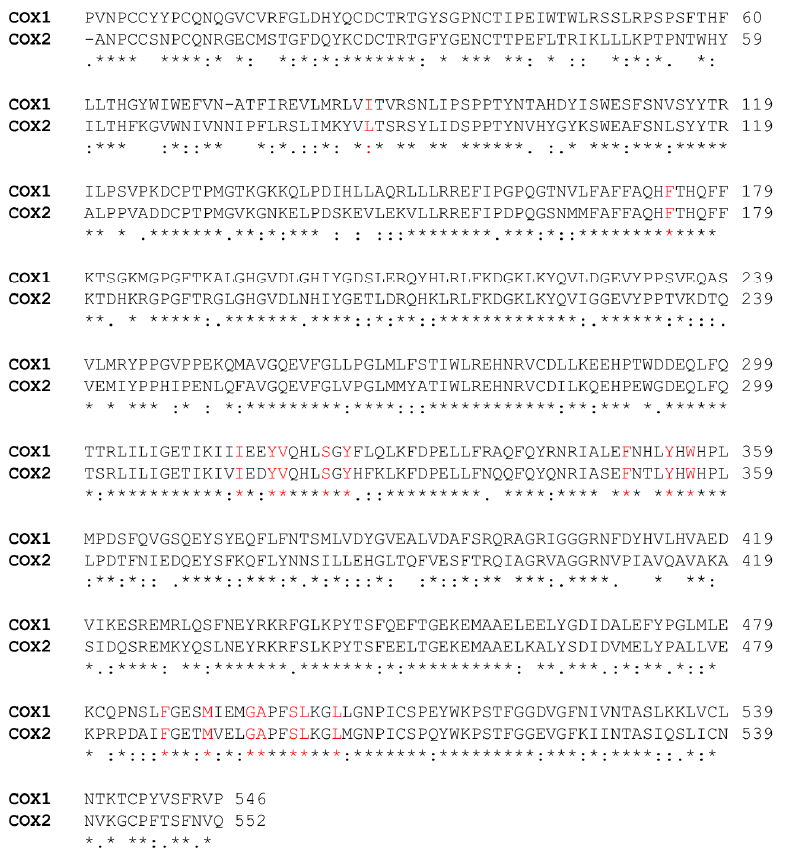
Figure 4. Pairwise sequence alignment between COX-1 and COX-2. The amino acids present in the catalytic site are depicted in red. Between the two proteins, large groups of identical amino acids were found, and the specified pairing is marked with an asterisk (*). An intermediate pairing, such as conservative substitutions between the two COX isozymes are depicted using a colon (:) or dot (.), while the lack of similarity was depicted as white space. The 17 catalytic amino acids provided by the blast analysis are depicted in red. The single difference in terms of amino acid substitution in the catalytic site between the two enzymes is the presence of Ile86 in COX-1, while in COX-2, at the same position, Leu86 can be found.